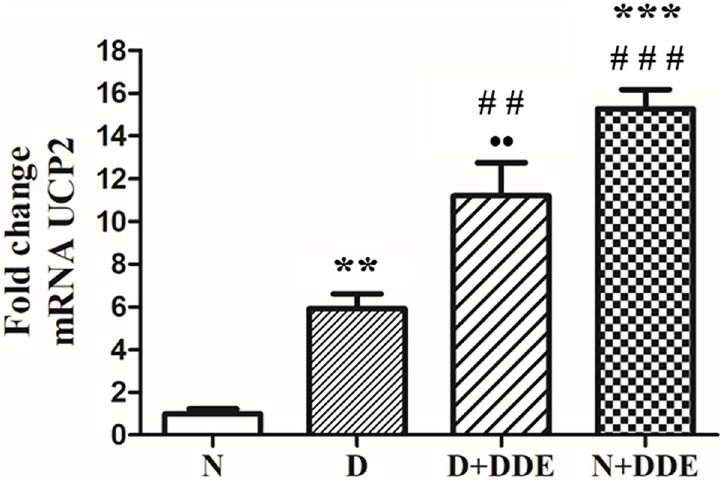
Fig 7. UCP2 gene expression in rat liver. UCP2 mRNA levels were determined by using real-time PCR analysis. The amount of UCP2 transcripts was normalized to that of β -actin mRNA and converted in fold change, compared with rats fed with a standard diet (N group). Significance of differences is shown. �� p < 0 . 01 vs. N; ��� p < 0 . 001 vs. N; ## p < 0 . 01 vs. D; ### p < 0 . 001 vs. D; •• p < 0 . 01 vs.